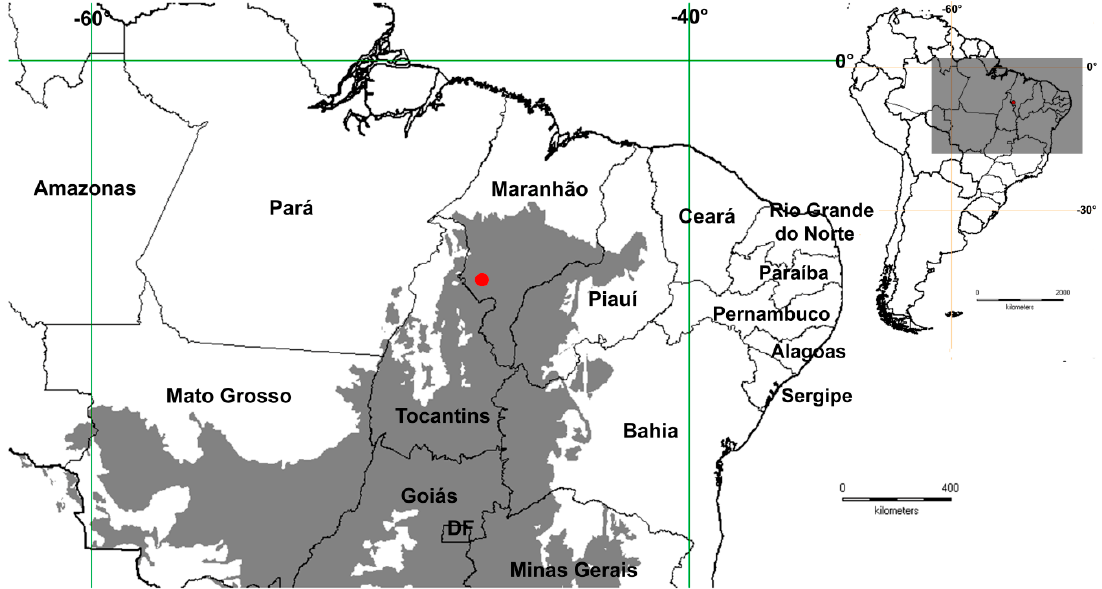
Figure 3. Geographic distribution of Mimosa carolina in northeastern Brazil. The dark gray area in the large map represents the Cerrado ecoregion.